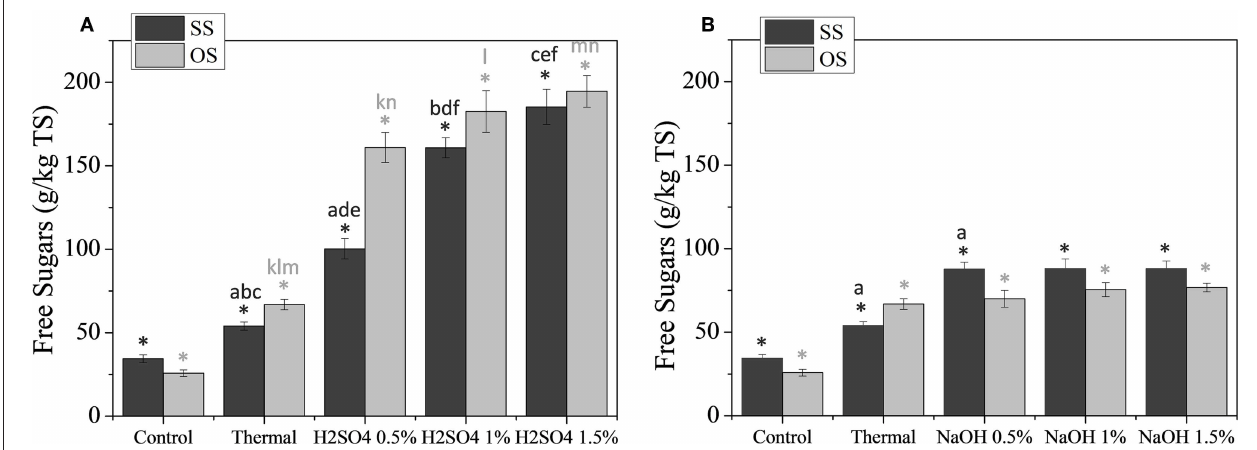
FIGURE 1 | Saccharification yields during thermochemical pretreatment of SS and OS using dilute H 2 SO 4 (A) , or mild NaOH (B) solutions. The results are mean ± SD from six different measurements ( N = 6). The statistical difference with the control (untreated biomass) is indicated by an asterisk above columns, whereas statistical difference among values is indicated by different letters above columns (Mann Whitney u